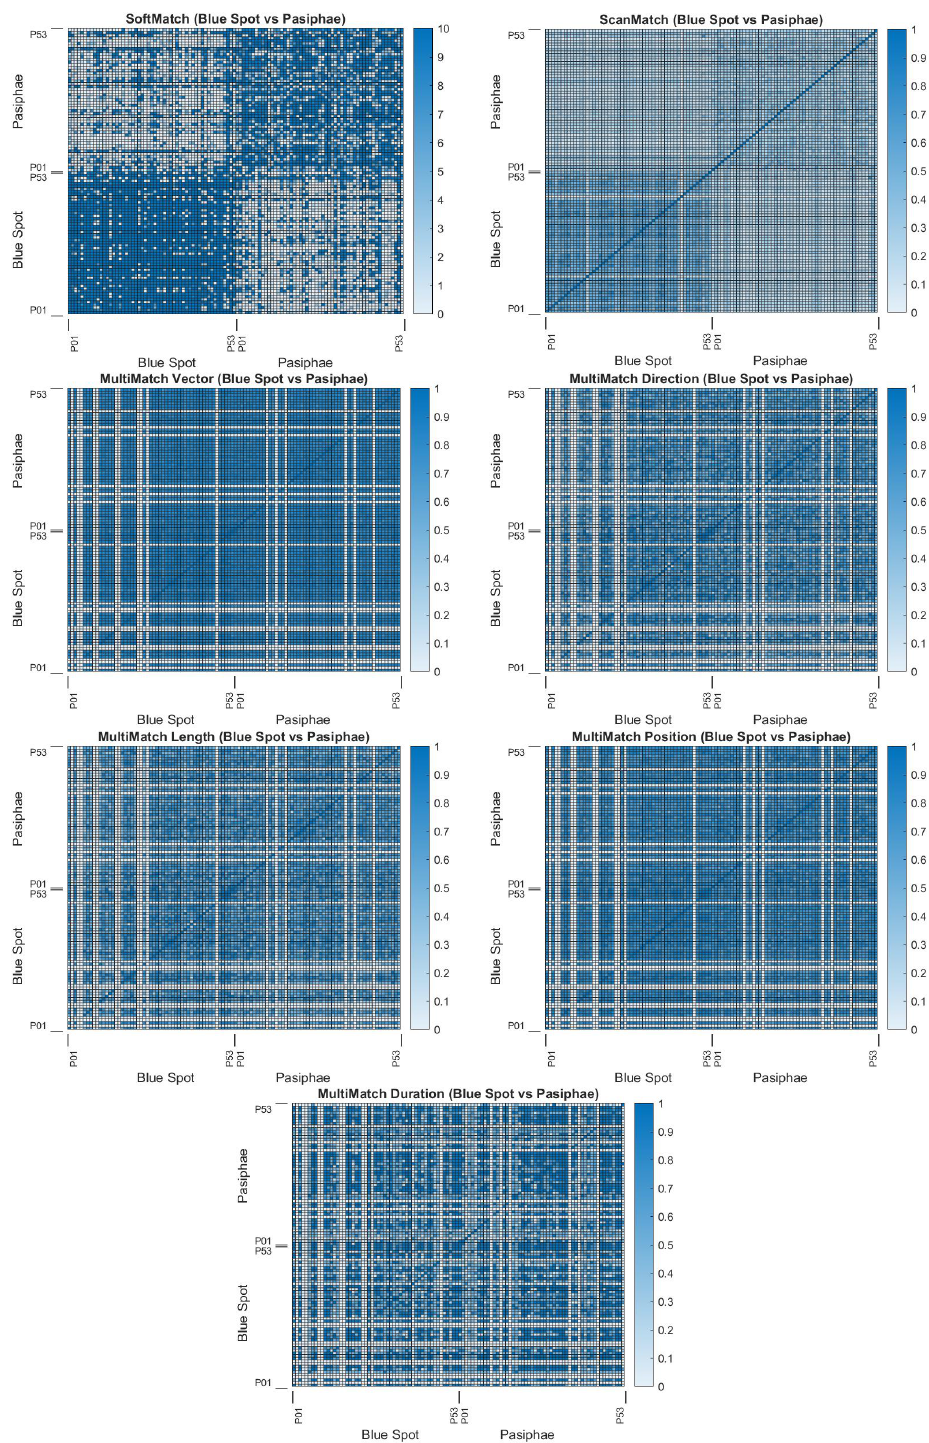
Figure A7. SoftMatch, ScanMatch, and MultiMatch heatmaps for empirical evaluation. Stimuli matched are Bernard Cohen’s Blue Spot (1966) and Jackson Pollock’s Pasiphae